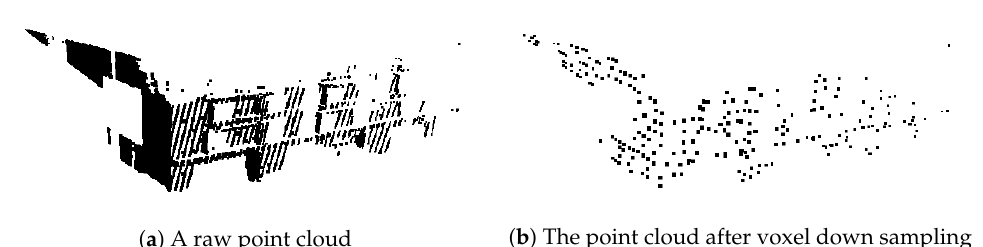
Figure 4. The same point cloud ( a ) before and ( b ) after voxel down sampling. The density of the point cloud becomes uniform and noise is